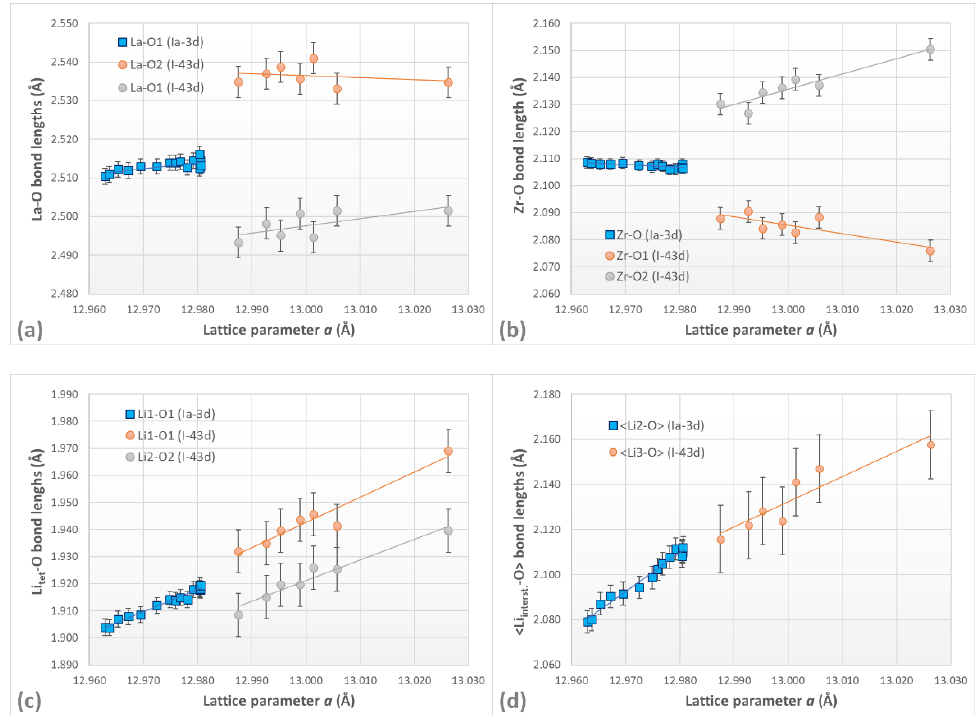
Figure 9. Variation of bond lengths in Al10-LLZO as a function of change in unit cell parameters with aging, from refinements of high-resolution X-ray diffraction data. ( a ) Smaller La – O bond lengths, ( b ) Zr – O bond length, ( c ) Li – O bond lengths at the regular tetrahedral sites (24 d , 12 a , and 12 b ), and ( d ) average Li – O bond lengths at the interstitial site (96 h and 48 e ) assuming a 4-fold coordination of the site.